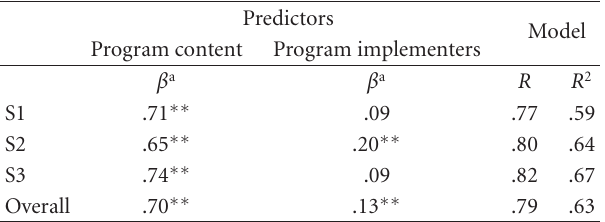
Table 5: Multiple regression analyses predicting program e ff ective-